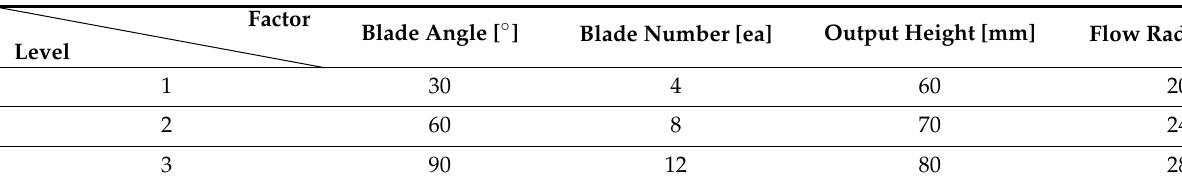
Table 1. Levels and design variables.